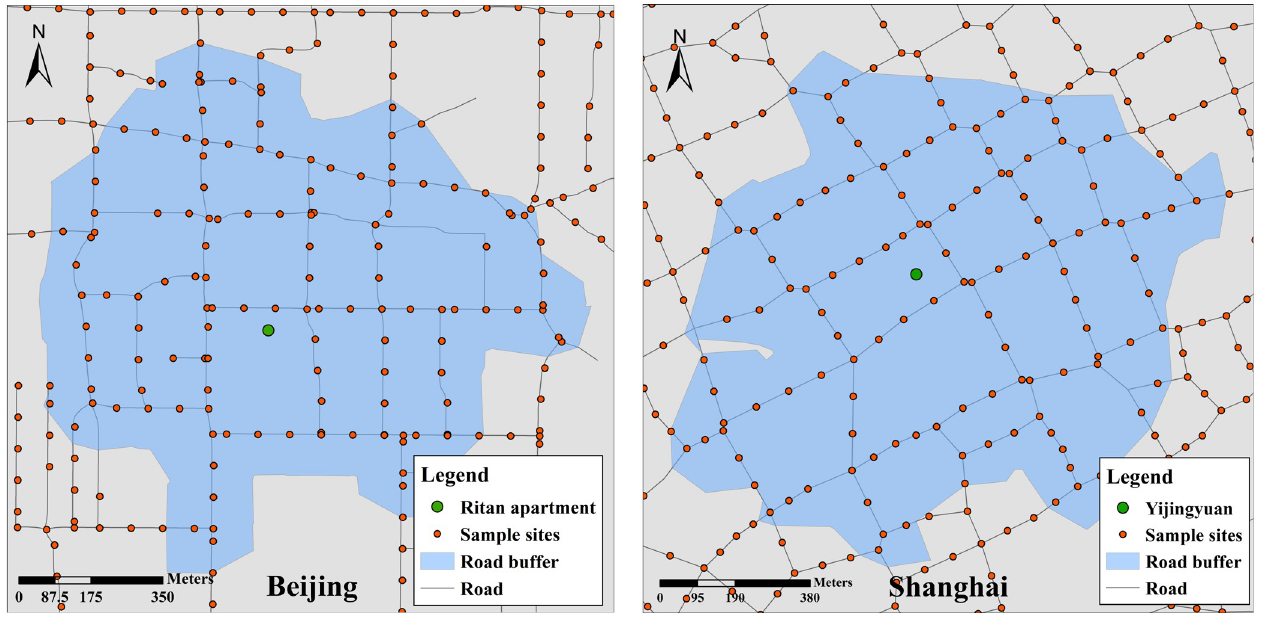
Fig 4. The road sites around two sample plots and their road buffer